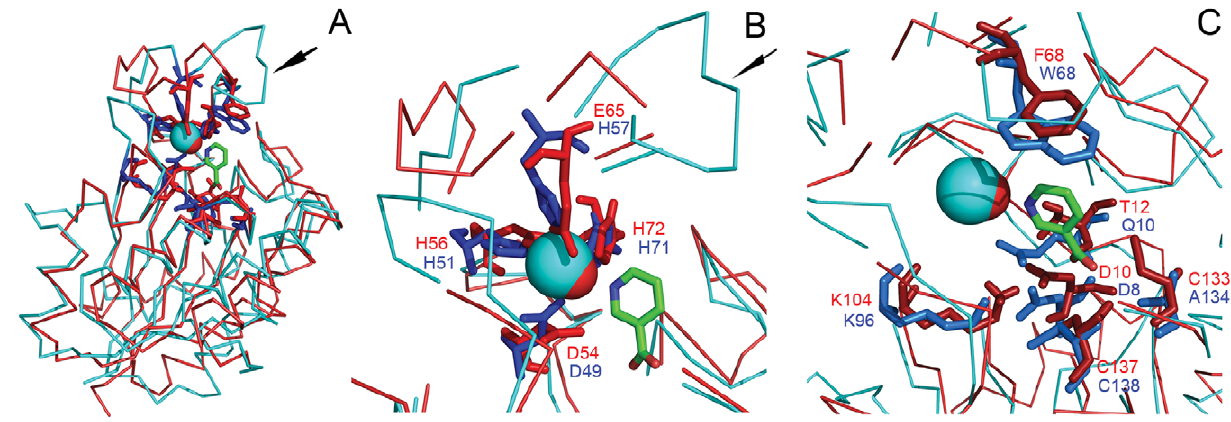
Figure 4. Structural alignment of modelled OiNIC and crystallized Mycobacterium tuberculosis MtPncA. A) Monomer of OiNIC is represented in red and monomer of MtPncA in blue. Fe 2 + and Zn 2 + are represented as blue and red spheres, respectively. The arrow represents the 51–71 loop of MtPncA. NAM is colored in green. B) Residues interacting with the metal ion. C) Residues forming the active site cavity and interacting with